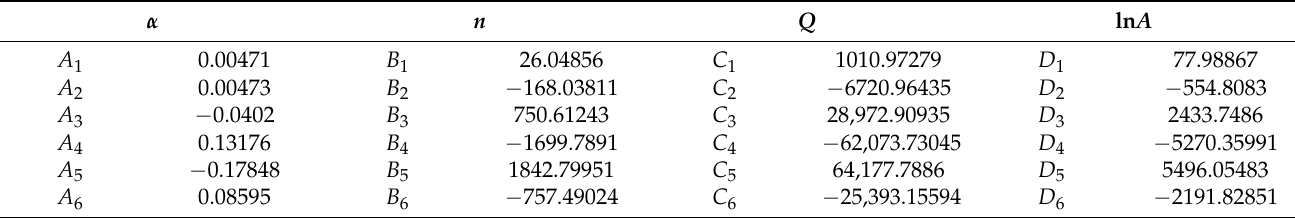
Table 1. Polynomial fitting parameters for Mo–1.5 wt% Al 2 O 3 .